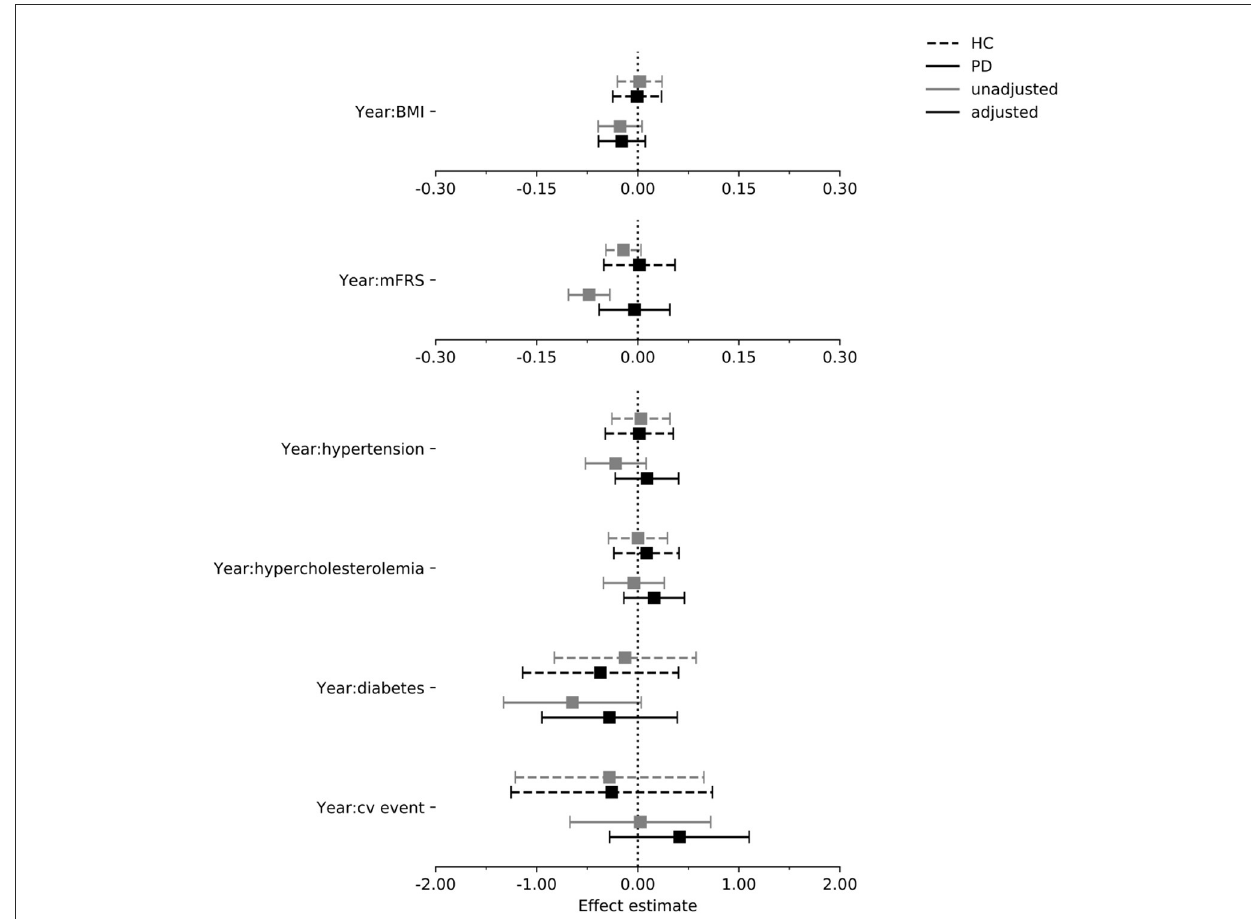
FIGURE5 Estimated effect of each exposure on the rate of change in the SDMT score per year in the PPMI cohort. Intervals are 95% confidence intervals. mFrs, modified Framingham risk score; BMI, body mass index; cv, cardiovascular; HC, healthy control; PD, Parkinson’s disease.